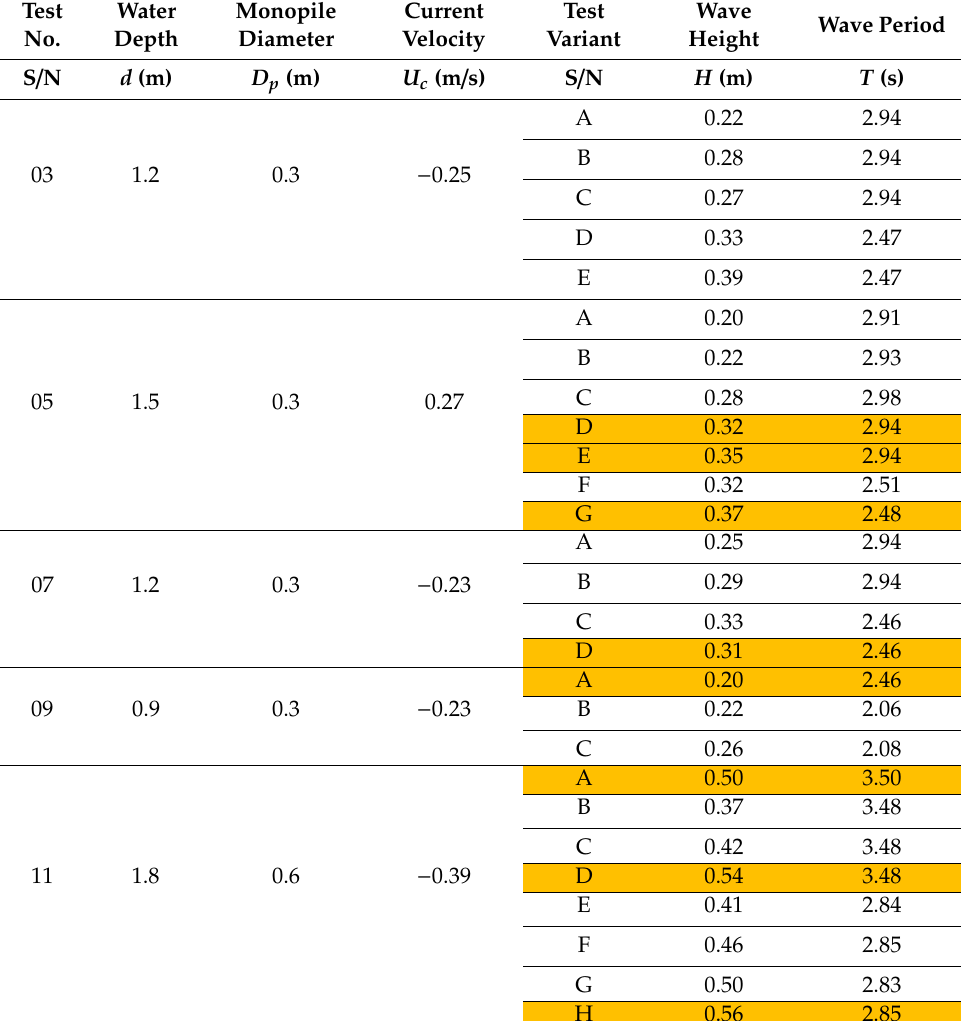
Table 4. Onset of motion measured test conditions. The highlighted conditions are the ones where the motion of scour protection material is spotted. S / N stands for the serial